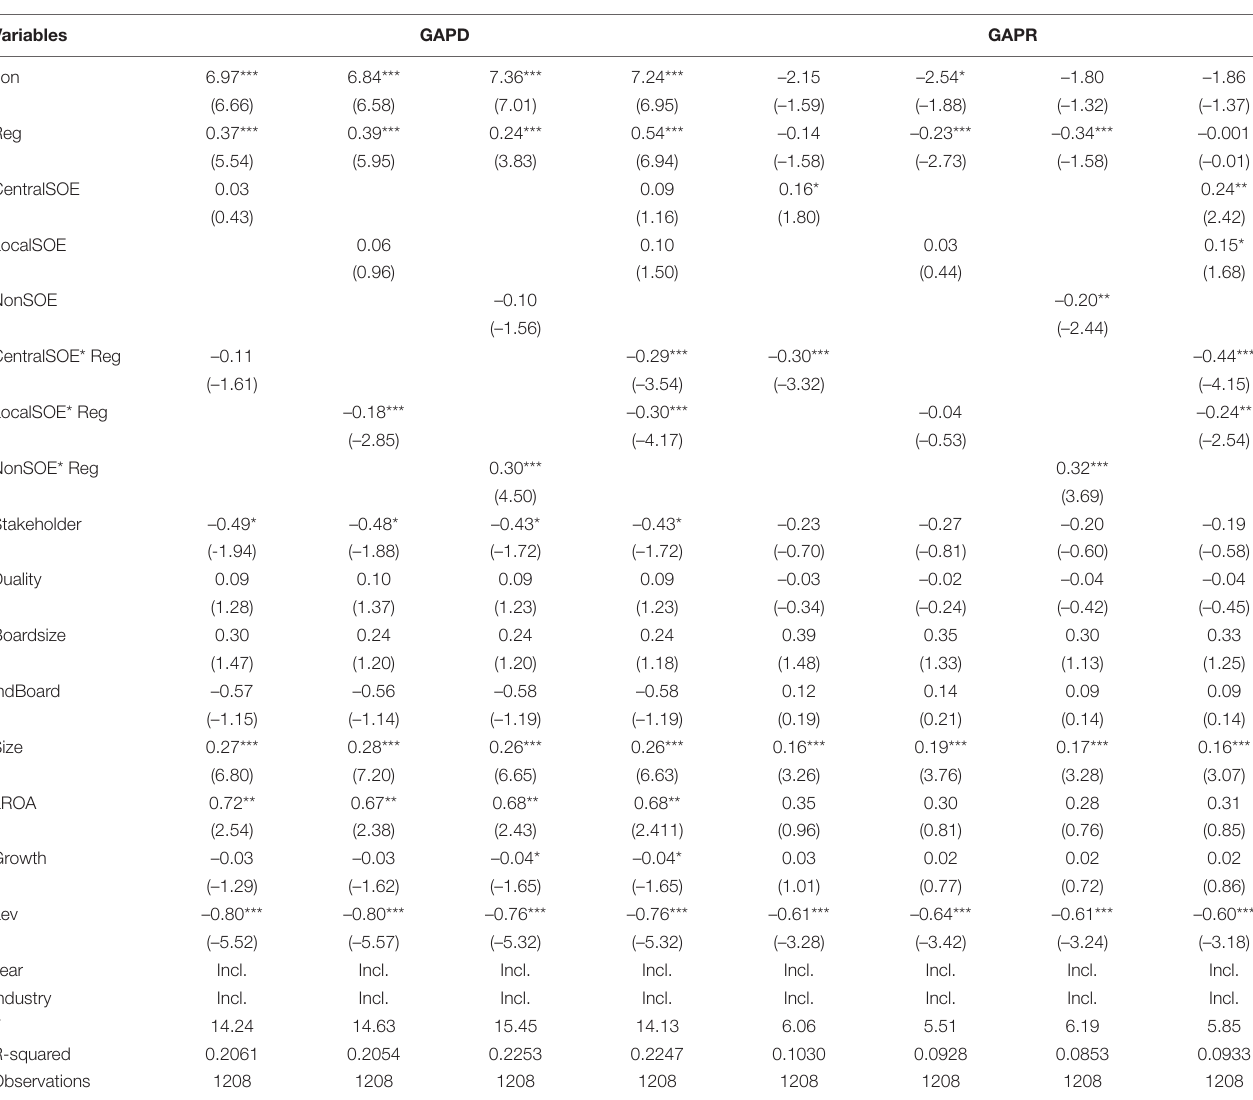
TABLE 8 | Robustness test using a pooled